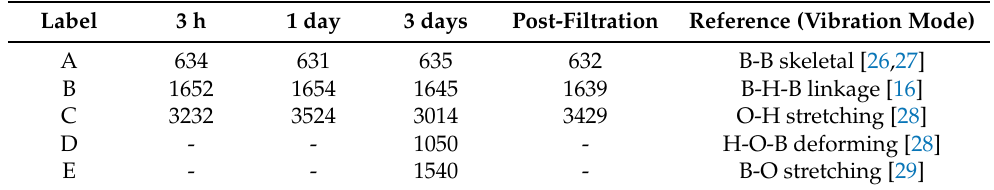
Figure 6. ( a – c ) FT-IRAS difference spectra of the solution samples with or without hydrochloric acid (HCl) taken at various reaction times: ( a ) 3 h, ( b ) 1 day, and ( c ) 3 days. ( d ) FT-IRAS difference spectrum of the filtrate after filtration of the sample ( c ). Peaks are labeled with capital letters. Table 1. Summary of the assignment of the FT-IRAS peaks (Figure 6); the assignments are based on references [16,22–24,26,27] (unit: cm − 1